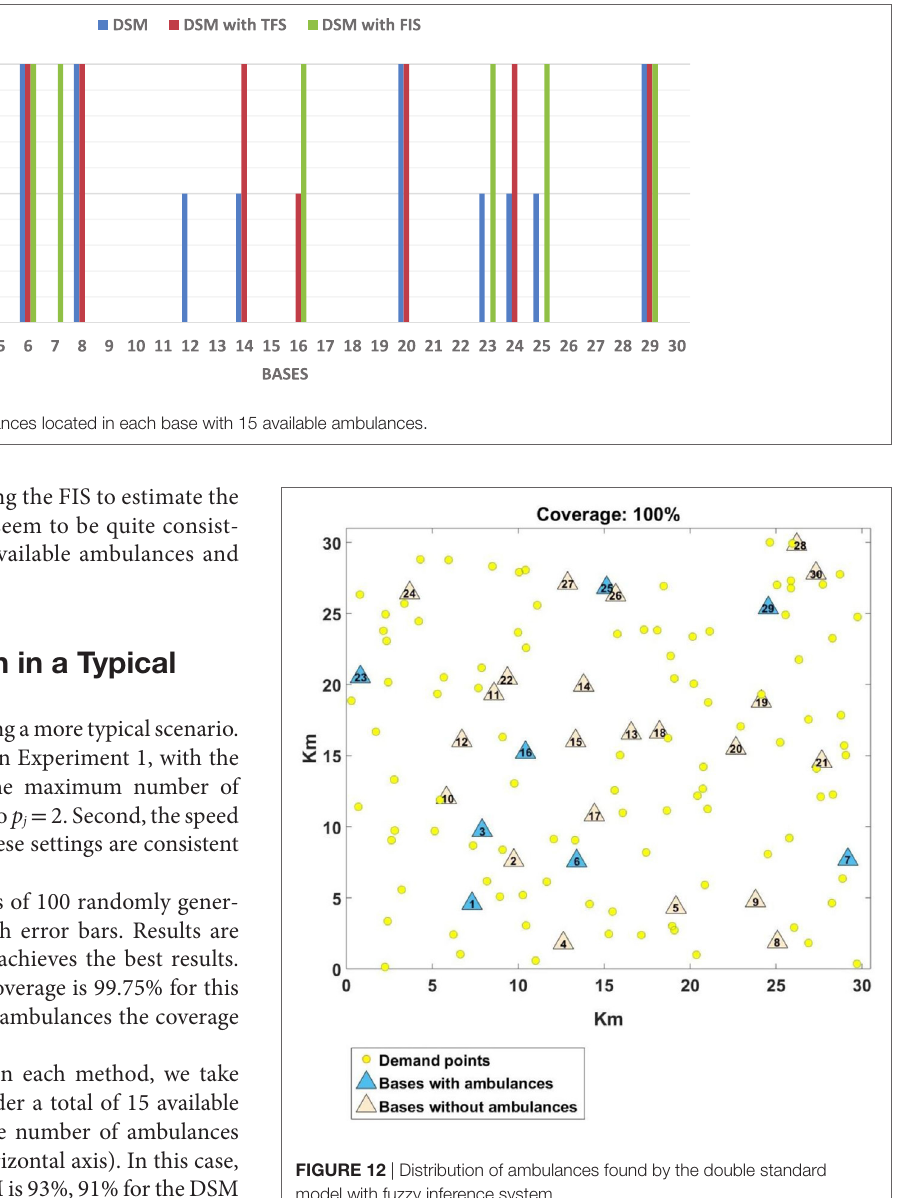
FigUre 12 | Distribution of ambulances found by the double standard model with fuzzy inference